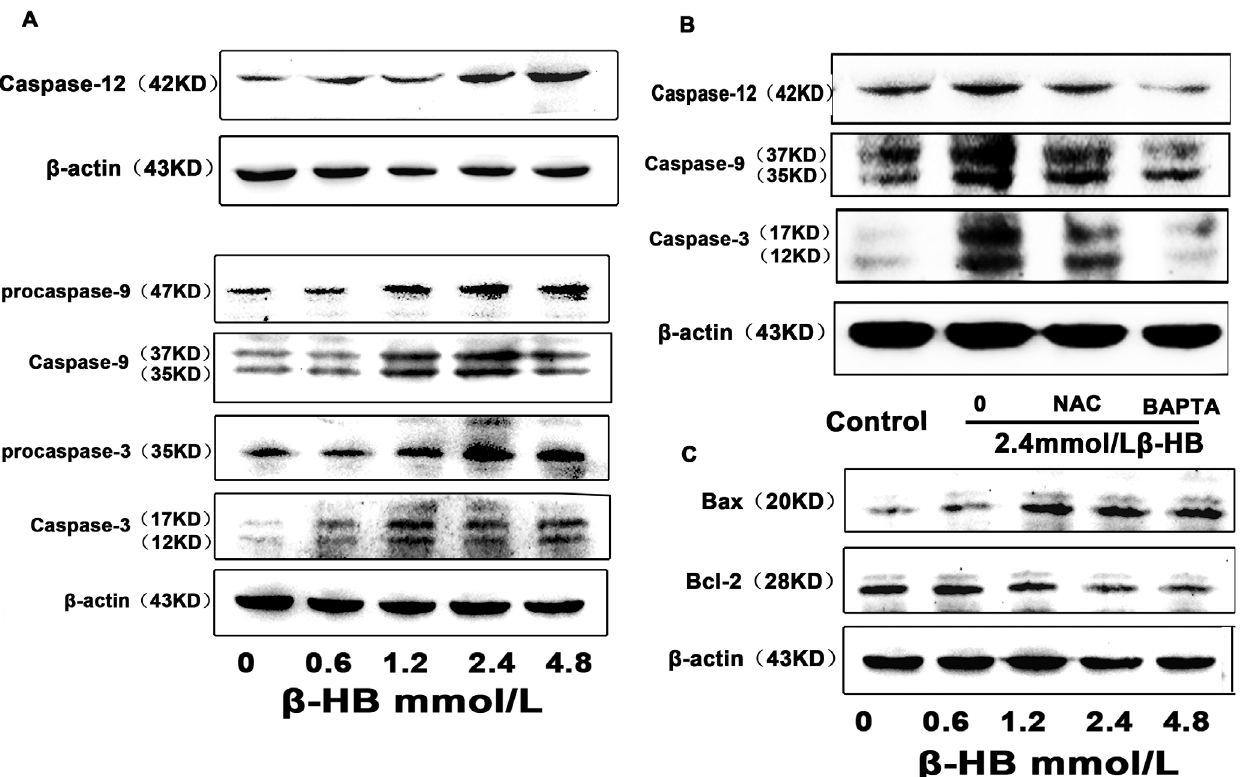
Figure 5. Effect of b -HB on the expression of cleaved caspase-12, -9, -3 Bax, Bcl-2 in BSMCs. A) and B) Cells were incubated 48 h with b - HB (0, 0.6, 1.2, 2.4 or 4.8 mM) in serum-free medium. Cleaved caspase-12, - 9, - 3, Bax and Bcl-2 were detected by Western blot. C) Cells were incubated 48 h with b -HB (0, 2.4 mM) in serum-free medium in the absence or presence of NAC (1 mM) or BAPTA/AM (15 m M). Cleaved caspase-12, - 9, - 3 were detected by Western blot.